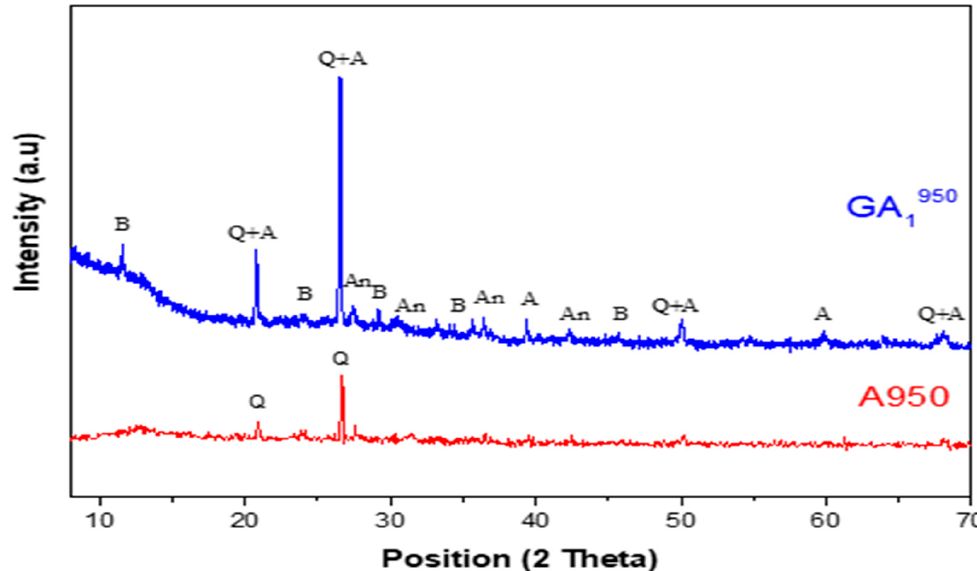
Figure 10. Diffractograms of GA 1950 geopolymer aged 7 days and A950 clay with Q—Quartz (01-082-0511), I—Illite (00-026-0911), A—Aluminum phosphate (01-084-0853), An—Anorthite (00-012-0301), B—Brushite (00-011-0293).